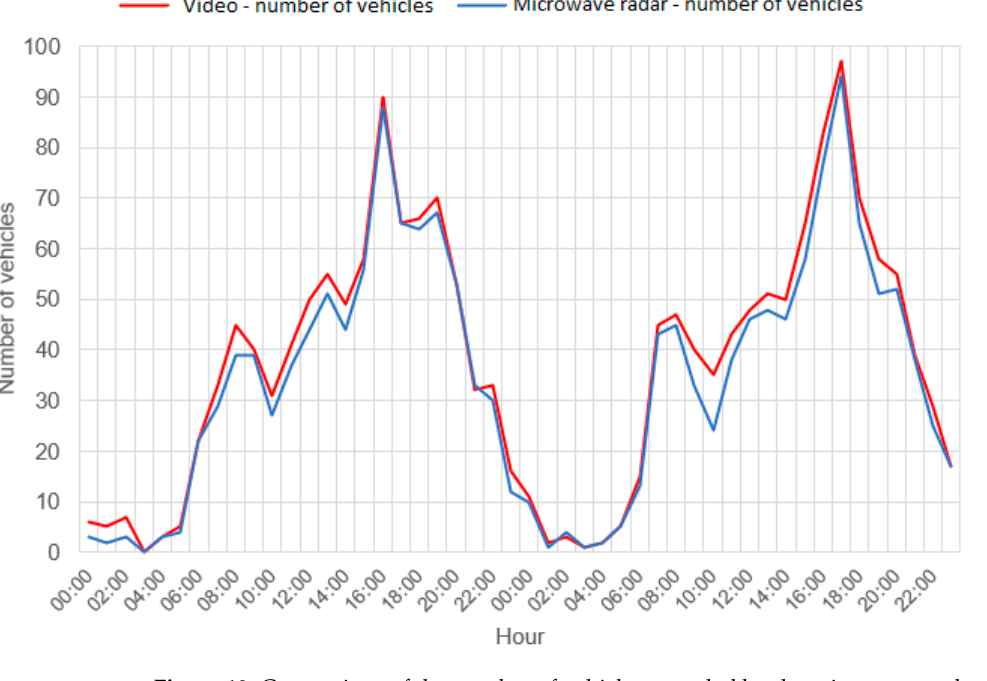
Figure 9. Comparison of the number of vehicles recorded by the microwave radar with the actual number of bicycles (the measuring station at Ś wi ę tokrzyska street) (own study).